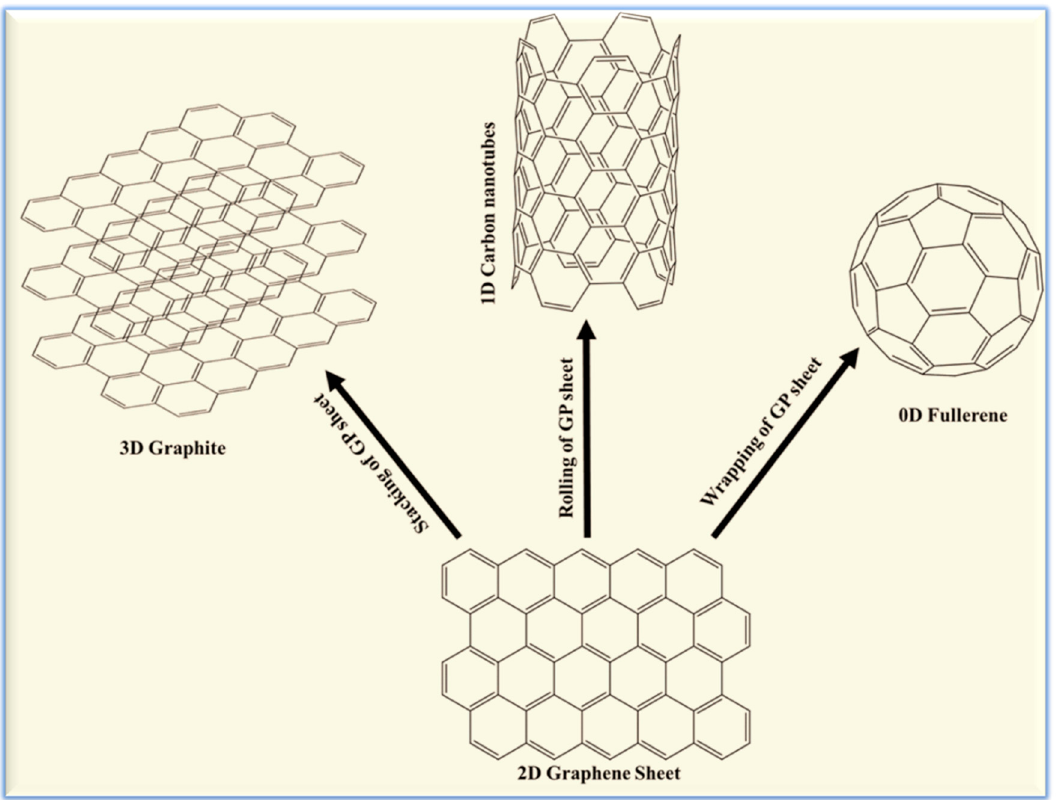
Figure 16. Schematic presentation of the relationship between different allotropes of carbon [9]. Redrawn from [9].